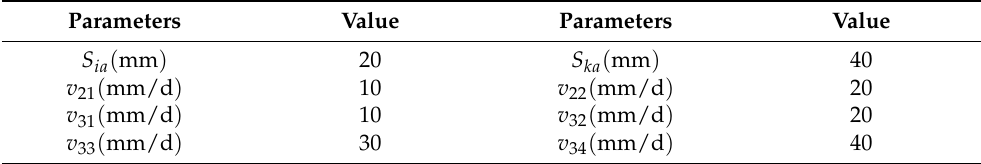
Table 6. Thresholds of the Shangmao landslide.